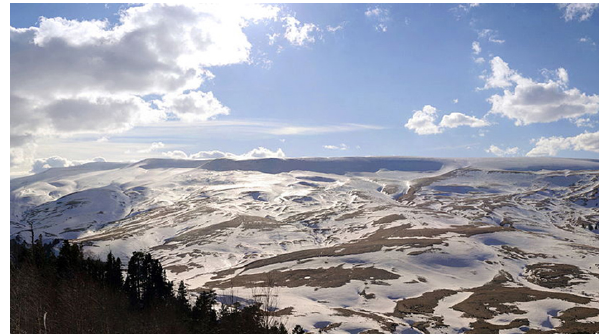
Figure 2. Typical terrain in the Lagonaki region.